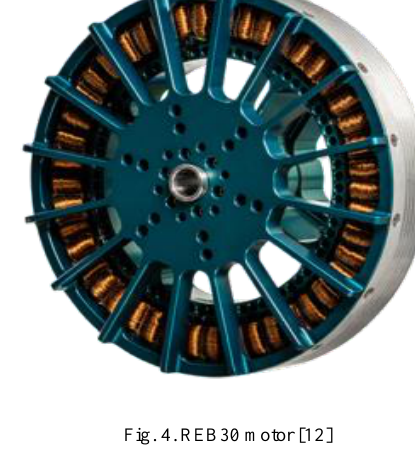
Fig. 2. View of the F23 Lightweight engine [21]